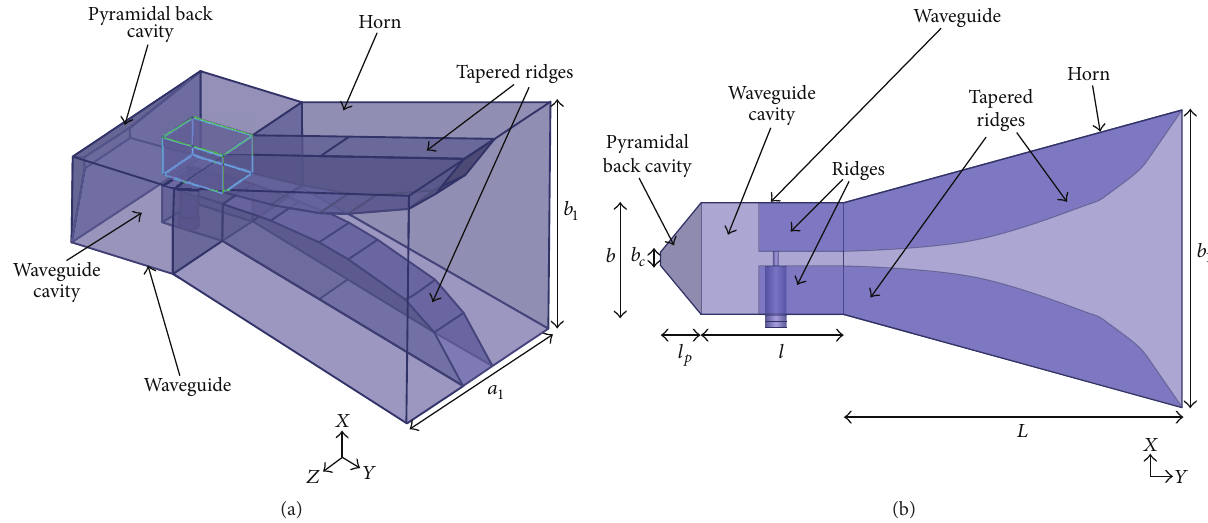
Figure 2: Geometry of the double-ridged horn antenna designed for breast microwave imaging system; (a) 3D view and (b) side view.